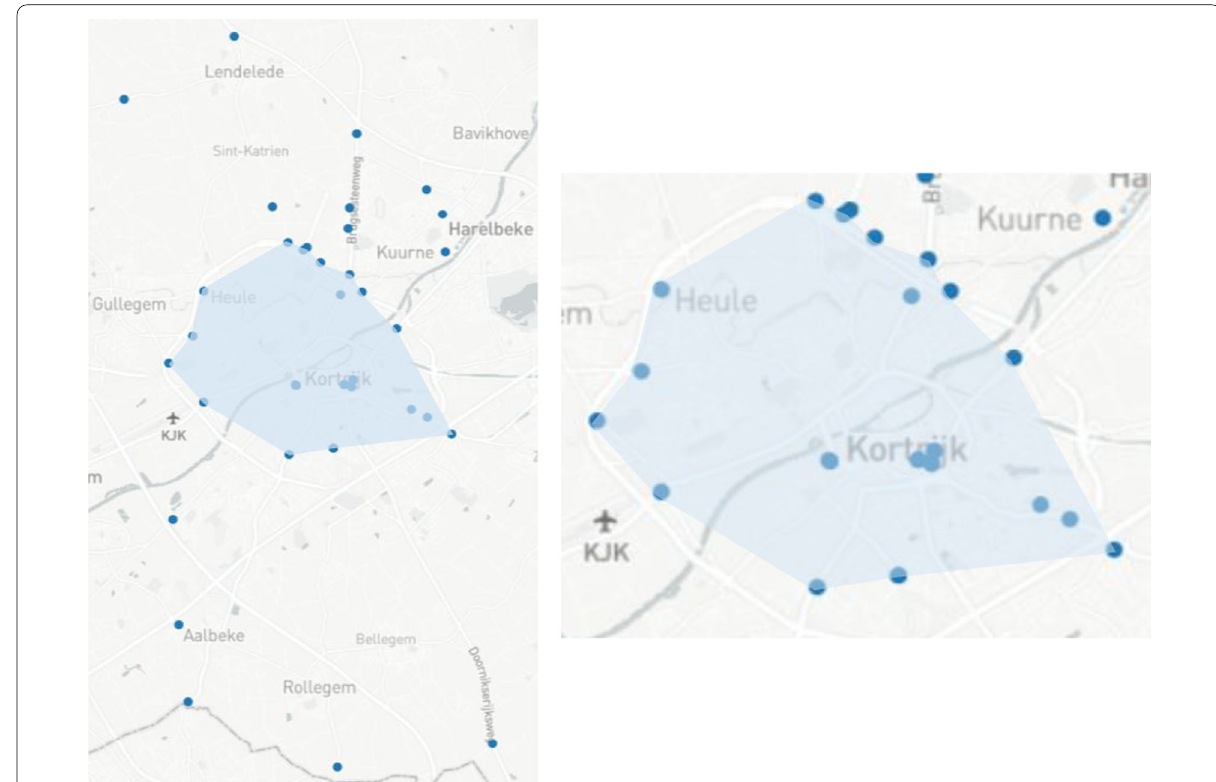
Fig. 4 Map of ANPR cameras in Kortrijk with the city center displayed in more detail